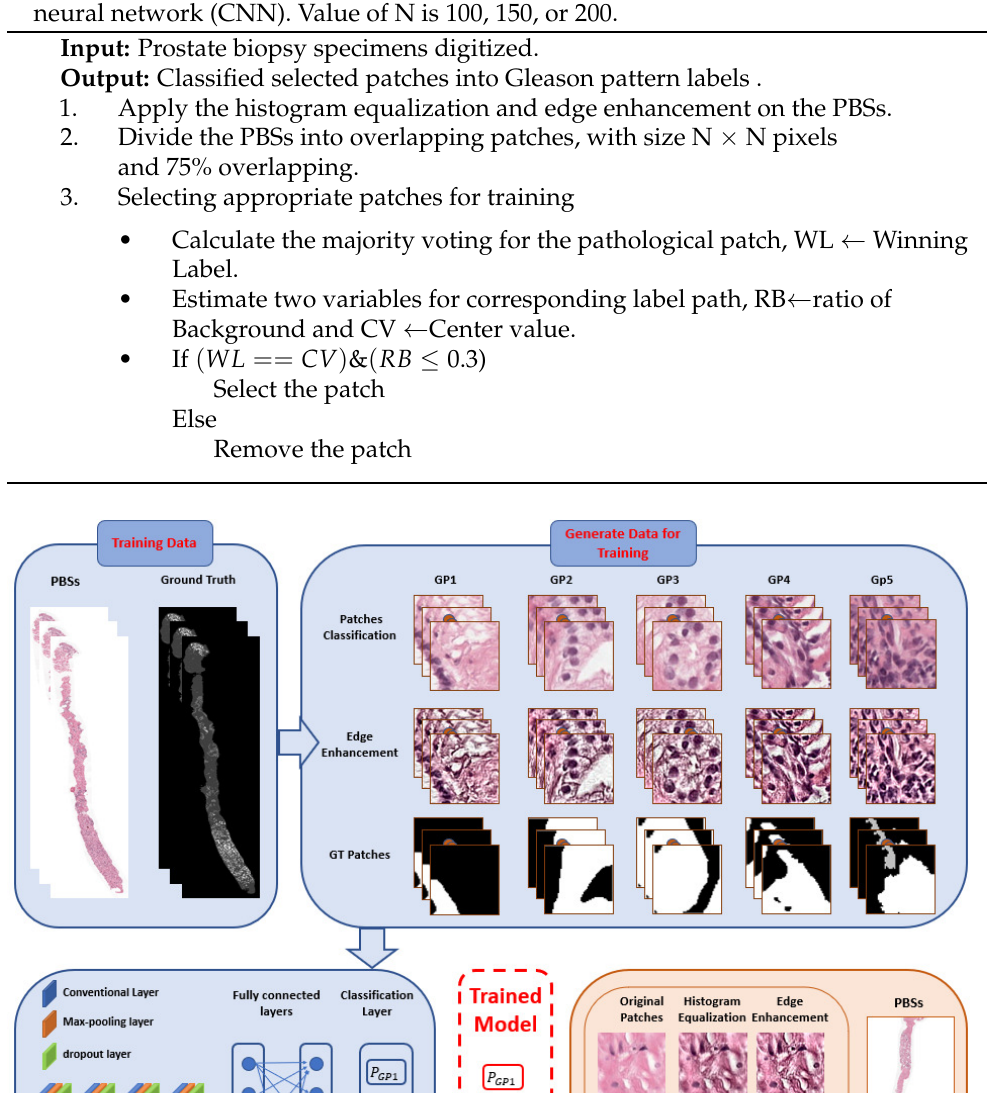
Algorithm 1: Preprocessing step of developing input data for a convolution